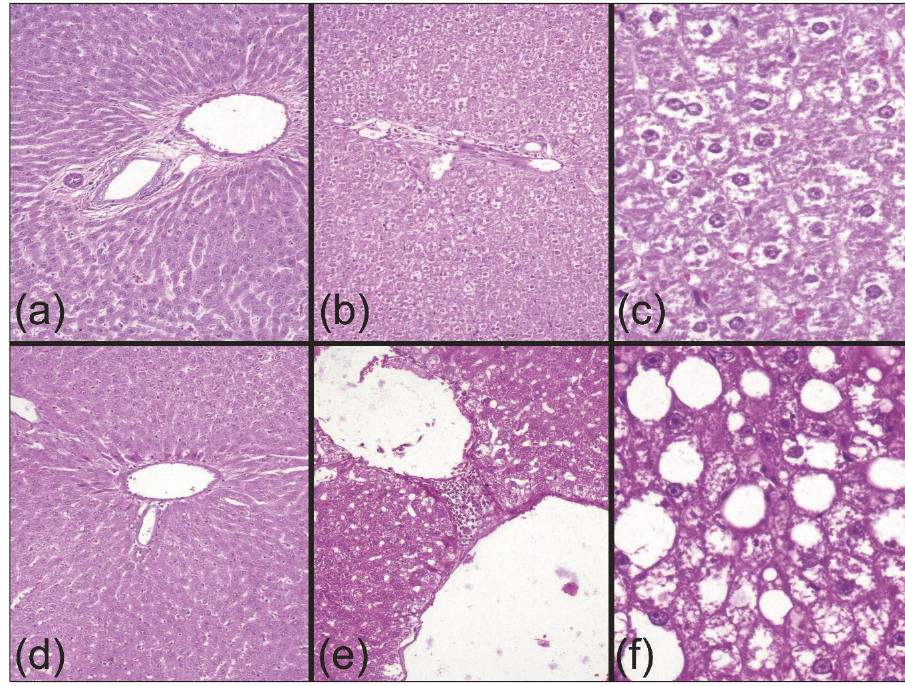
Fig. 4. Histological analysis of the liver in rats in the NAFLD-10 group consuming sucrose for 10 weeks: (a) normal hepatic parenchyma (10x) in control group, (b) scarce mononuclear inflammatory infiltrate in the stroma of portal spaces (10x) and (c) hepatocytes without alterations (mild portal hepatitis) (40x). Rats in the NAFLD-20 group consuming sucrose for 20 weeks: (d) normal hepatic parenchyma (10x) in control group; (e) lymphocytes in the portal space stroma, in addition hepatocytes with large lipid vacuoles (10x) and (f) morphological detail of hepatocytes with large lipid vacuoles (steatosis grade 1) (40x). Hematoxylin and Eosin.